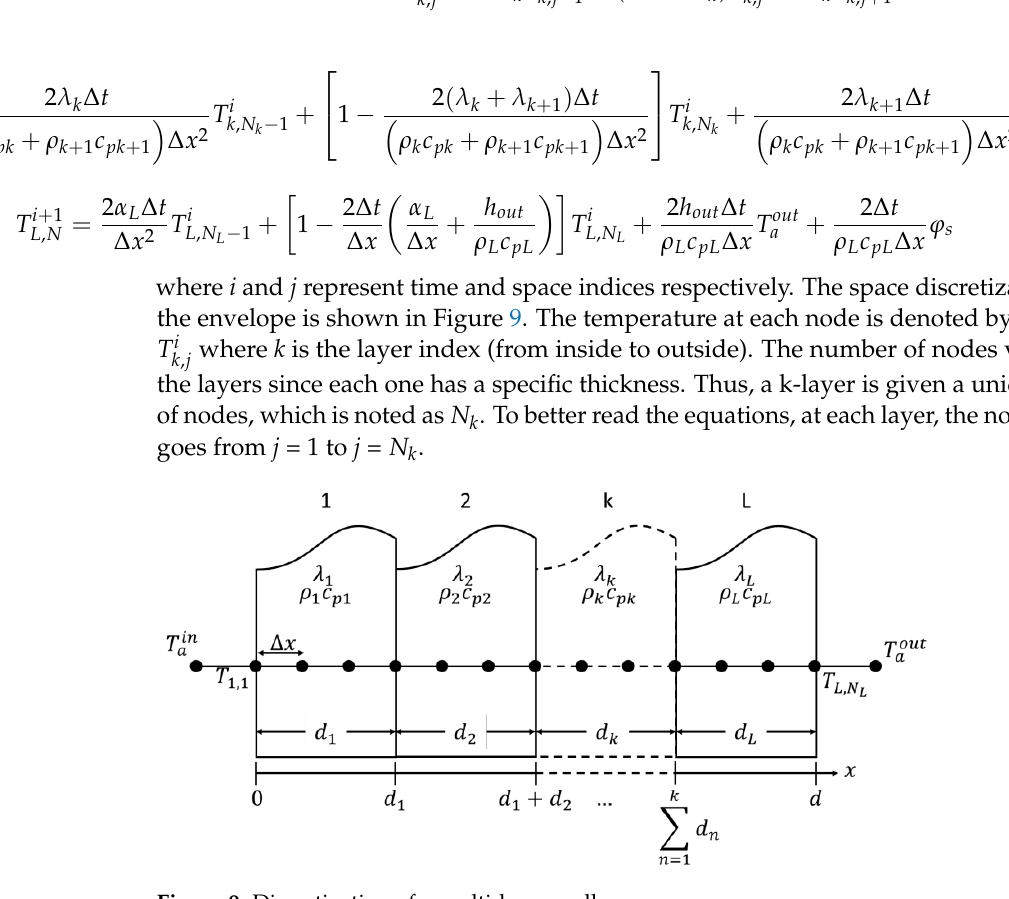
Figure 9. Discretization of a multi-layer wall. The mesh size ∆ x was set equal to one millimetre to make sure that all